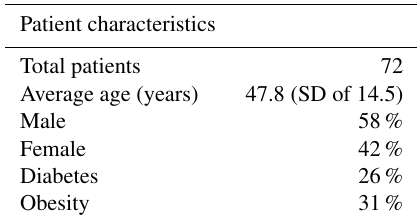
Table 1. Patient characteristics for subjects who met inclusion cri- teria ( n = 72).